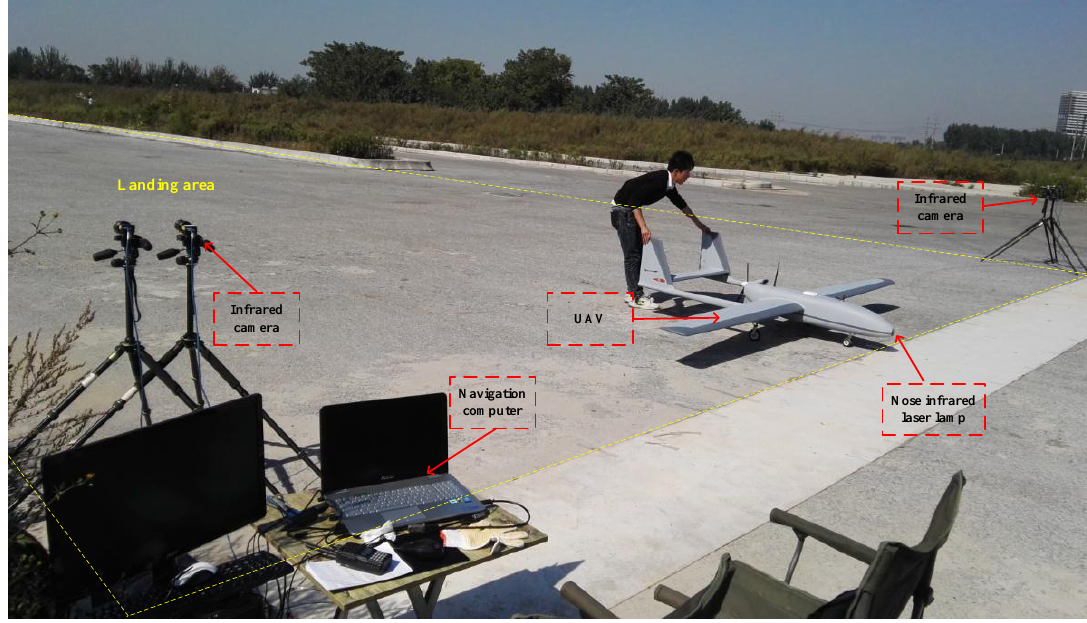
Figure 3. Ground-based landing